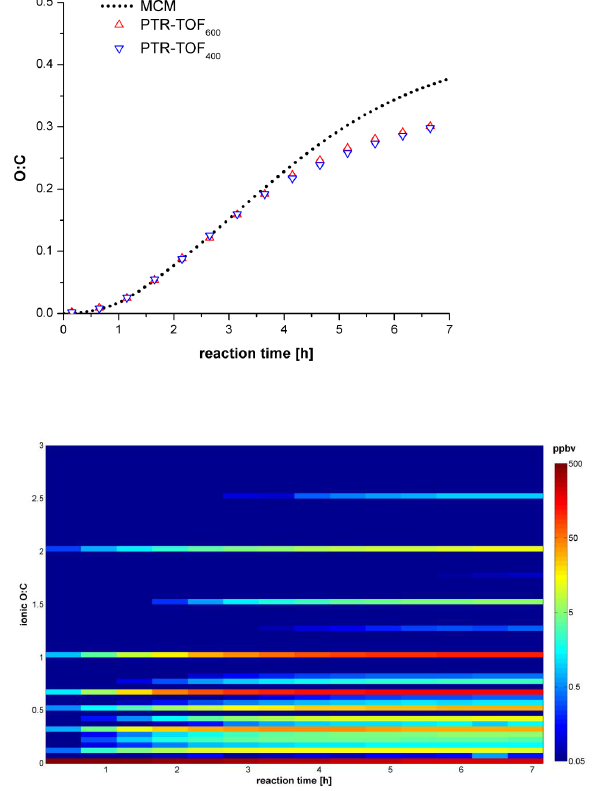
Fig. 6. (a) Measured total O:C ratios (PTR-TOF 600 and PTR- Figure 6. a) Measured total O:C ratios (PTR-TOF 600 and PTR-TOF 400 ; data from experiments 3 TOF 400 ; data from experiments 1a and 1b, respectively) compared 1a and 1b, respectively) compared with the MCMv3.1 model output. b) Time evolution of 4 with the MCMv3.1 model output. (b) Time evolution of individual individual highly mass resolved PTR-TOF signals with different O:C ratios as observed 5 highly mass resolved PTR-TOF signals with different O:C ratios as during experiment 1a. 6 observed during experiment 1a.